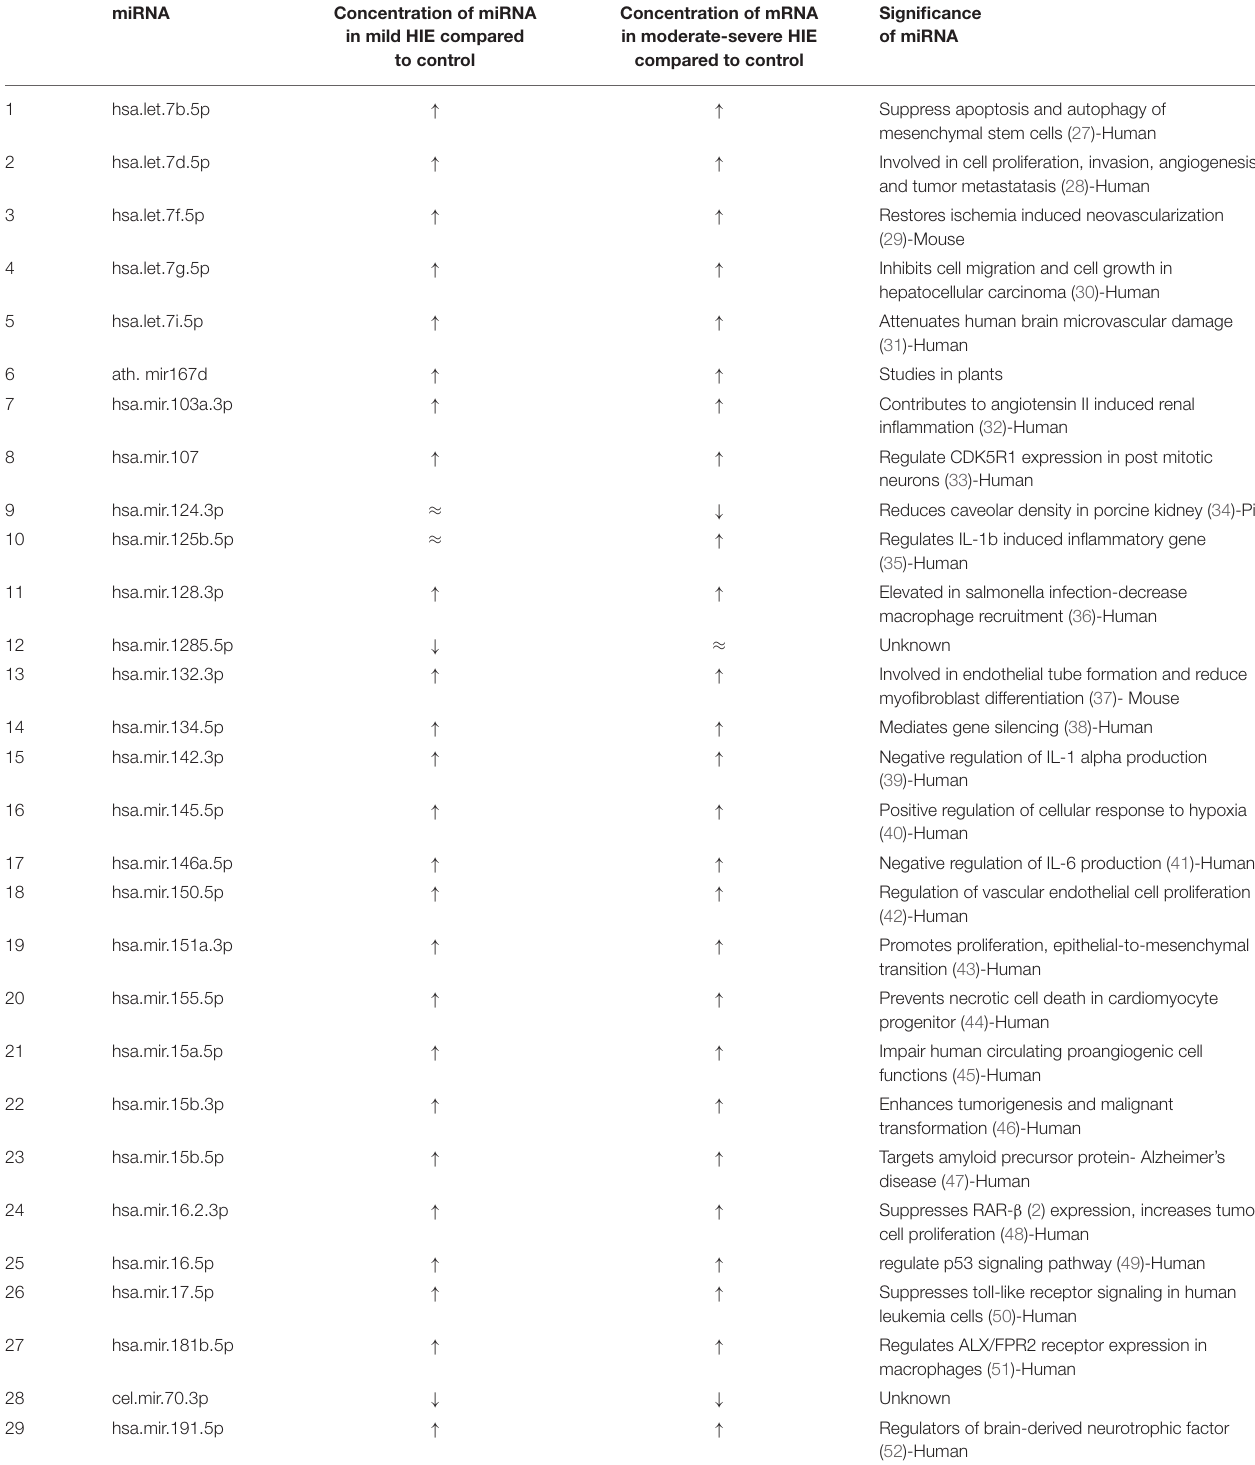
TABLE 4 | p -value of miRNA concentration in mild HIE verses healthy control, moderate to severe HIE verses healthy control and mild HIE verses moderate-severe HIE respectively. Significance Concentration of mRNA miRNA Concentration of miRNA of in moderate-severe HIE in mild HIE compared compared to control to control